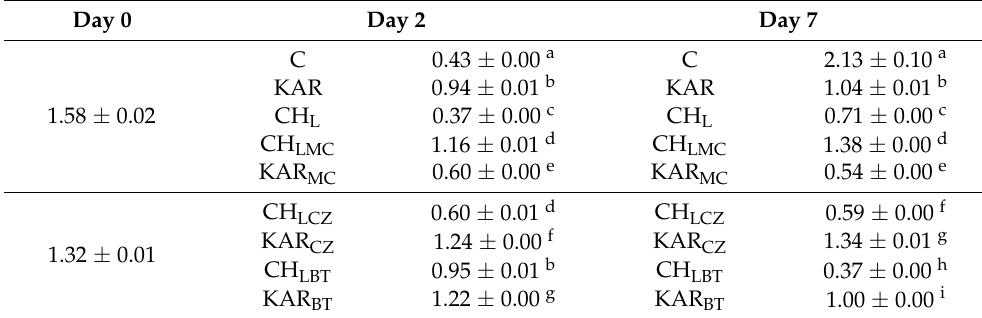
Table 7. Browning index (-) of Golden Delicious apples packaged in prepared film forming